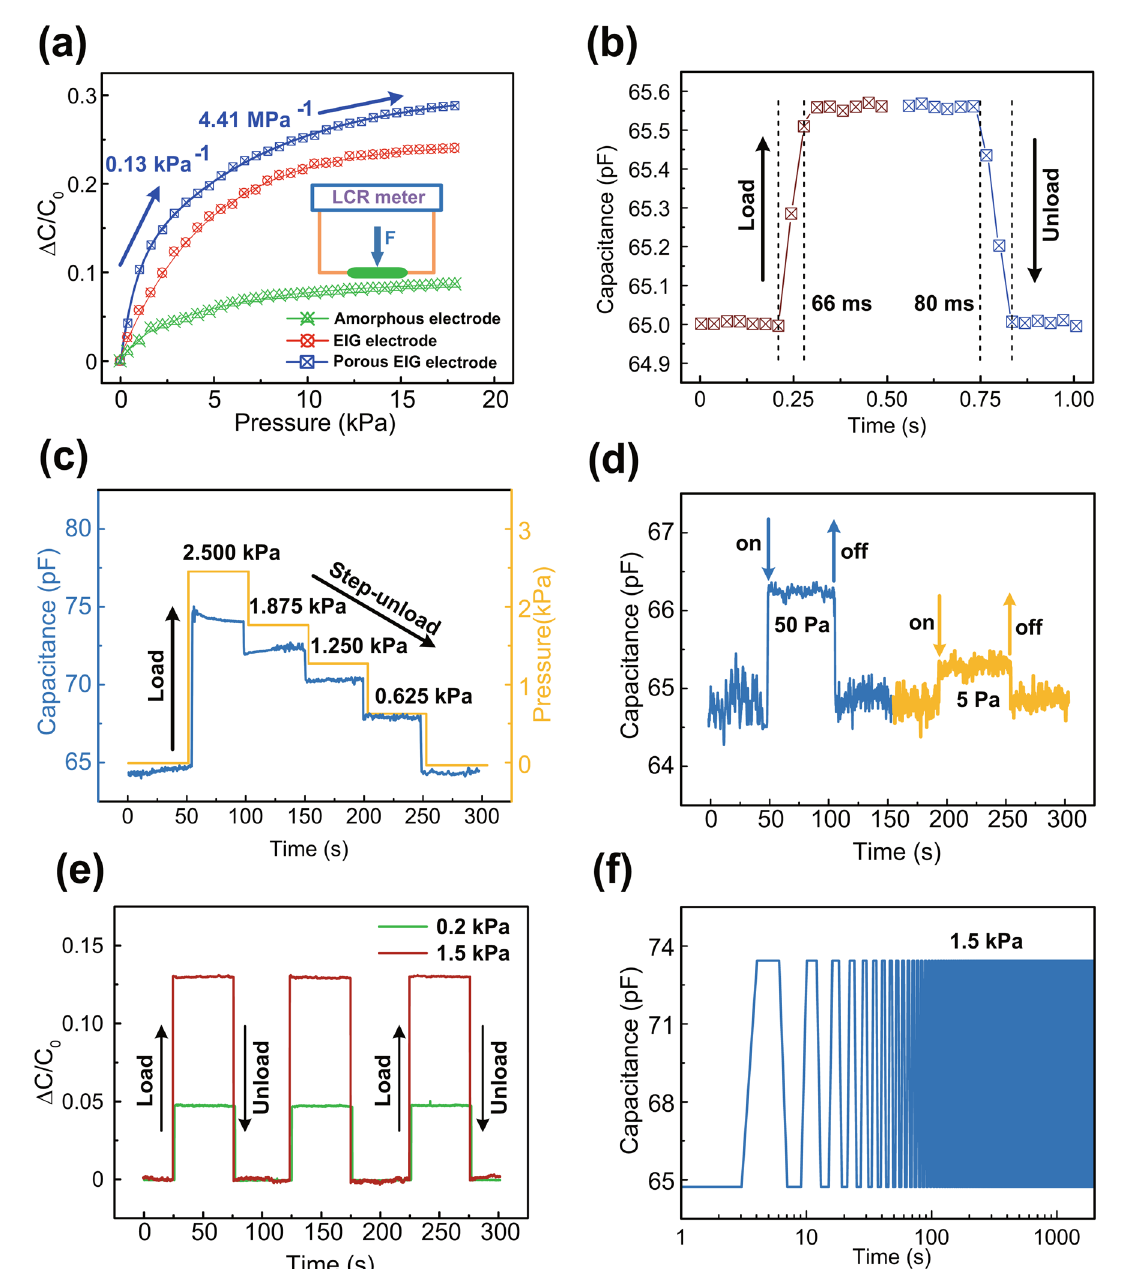
Fig. 3 Pressure‑sensing performance of the EIPG touch sensor. a Relative capacitance (Δ C / C ) versus normal pressure with various electrode types. b The instant response of the EIPG touch sensor shows response times of 66 ms. c Transient response to the load and step‑unload process. d Transient response of the sensor when placing and removing a paper or a polytetrafluoroethylene sheet on the substrate, corresponding to a pressure of only 50 and 5 Pa, respectively. e Δ C / C versus time under applied pressure of three cycles. f Durability testing under external pressure of 1.5